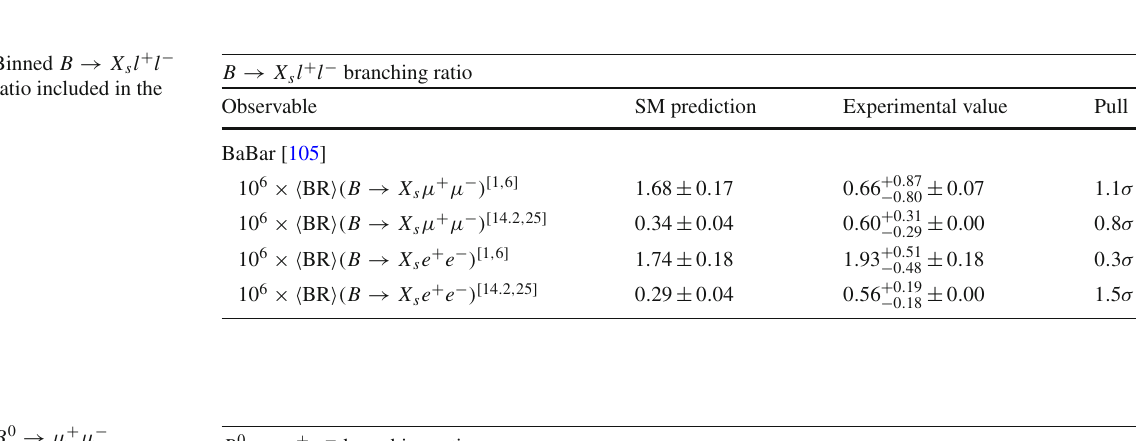
Table 23 B 0 s → μ + μ − branching ratio included in the global